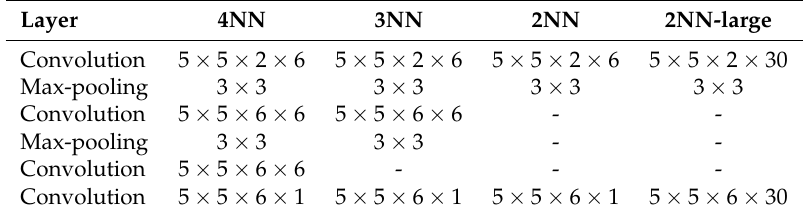
Table 1. Detailed architecture of our network. A convolution filter size is represented as Height × Width × Input Channels × Output Channels. A max-pooling filter size is represented as Height × Width. We exclude the bias and activation layers for readability. 2NN-large has the same number of parameters in convolution filters as